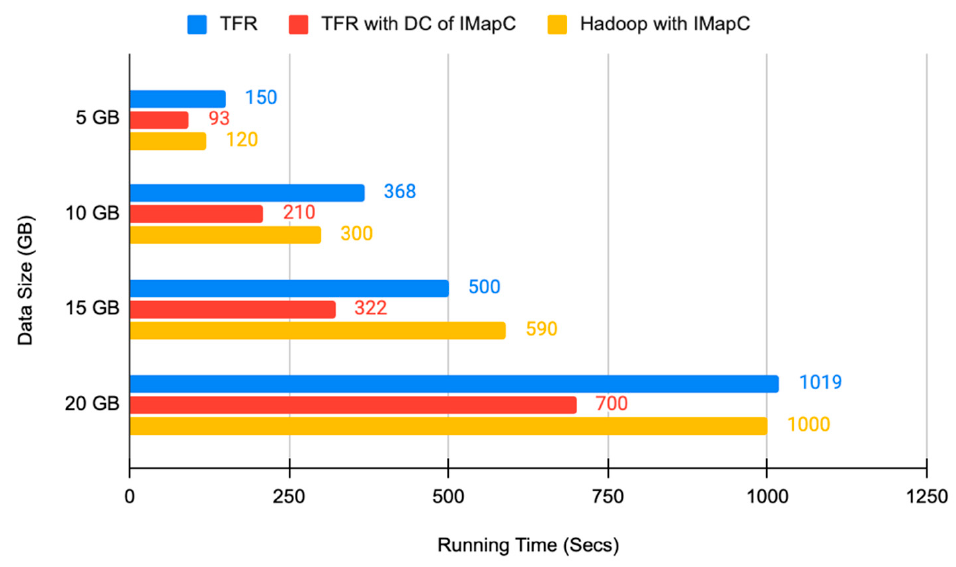
Figure 8. The execution time of WordCount program comparing TFR, TFR with IMapC, and Hadoop.